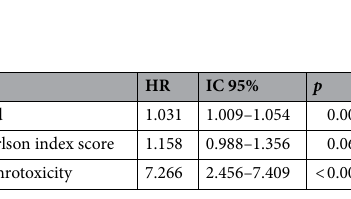
Table 6. Risk factors for all-cause in-hospital mortality, multivariate Cox regression analysis.